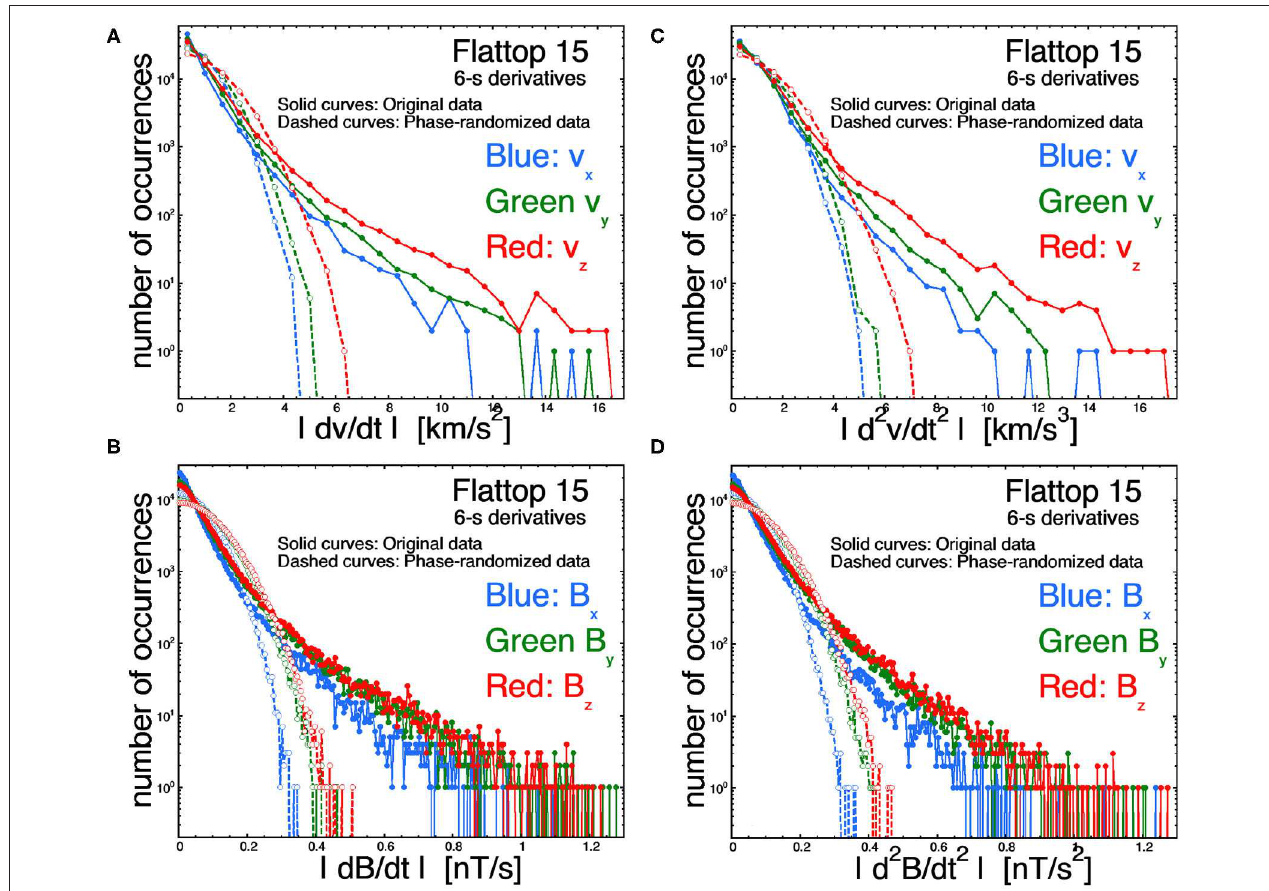
FIGURE 7 | Distributions of the measured first time derivatives (A,B) and second time derivatives (C,D) for (A,C) the radial (from the Sun) velocity v x for the Alfvénic solar wind fluctuations of Flattop 15, and (B,D) the radial component of the magnetic field B x for the Alfvénic solar wind fluctuations of Flattop 15. As labeled in each panel, three solid curves are for the three components of the measured time series, and three dashed curves are for the phase-normalized versions of the measured time series.